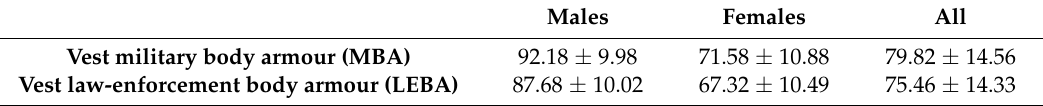
Table 3. Loaded weights (mean ± SD; kg) of officers, by gender and type of body armour.